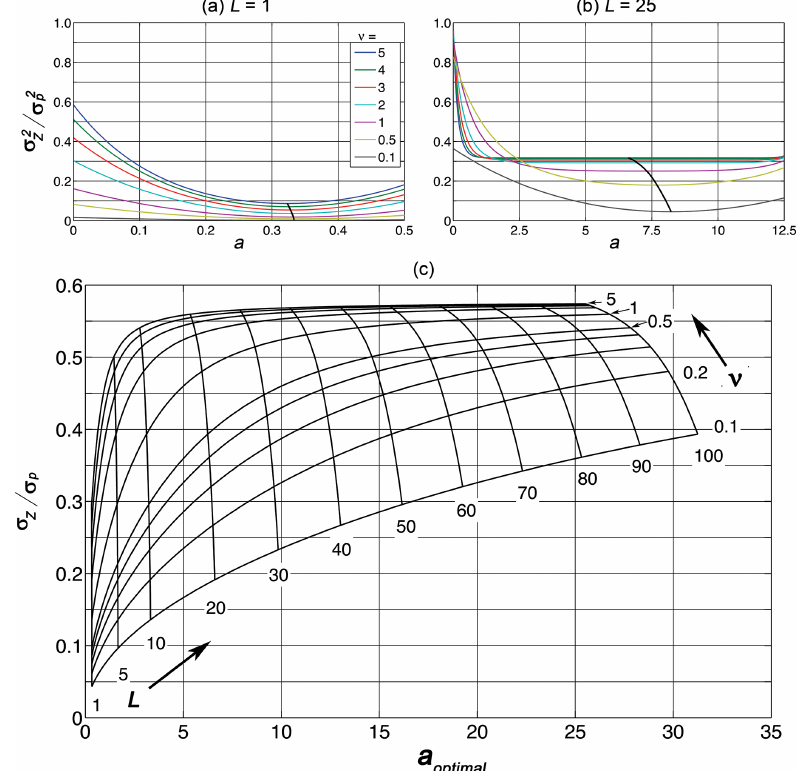
Figure 8. (a) and (b) Theoretical normalized squared error for the three-point pattern along a profile section in Fig. 5b, and for profile section lengths ( L ) of 1 (a) and 25 (b) . Each of the colored lines corresponds to a specific decay exponent, ν , and the black line marks the theoretical solution for a optimal . (c) Theoretical normalized error and a optimal for isolines of profile section lengths ( L ) and exponential decay exponents ( ν ) for the three-point pattern along a profile section of length L in Fig.